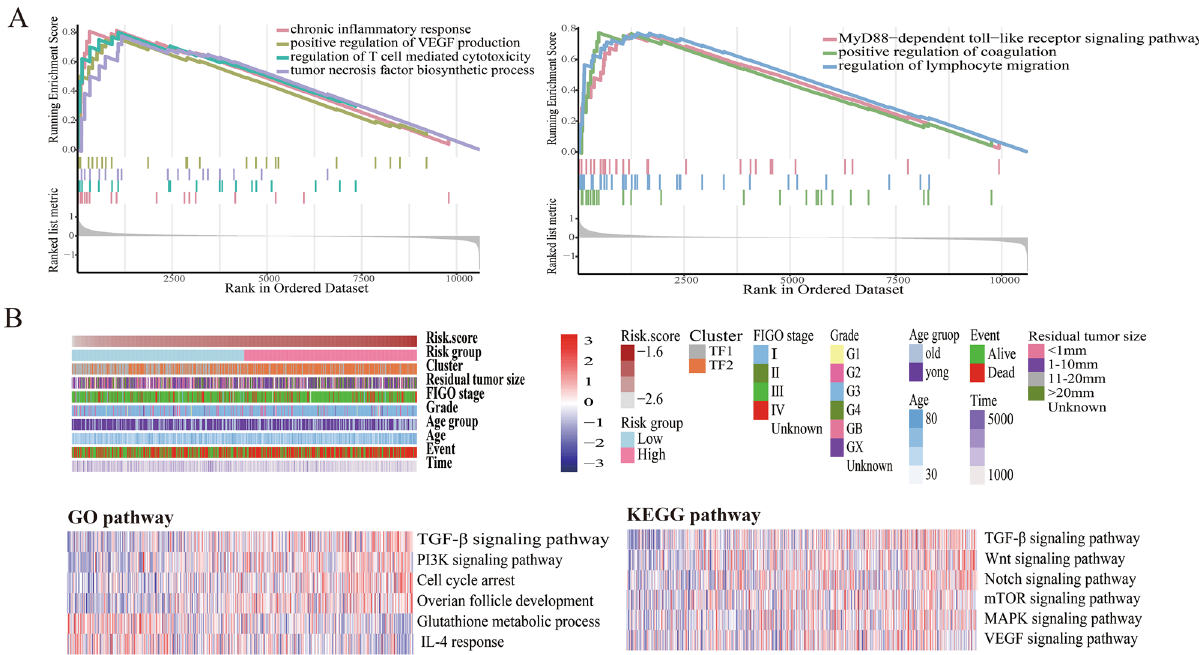
Figure 7. Functional annotation of TFs related prognostic signature. ( A ) GSEA assay to identify the different pathways between high-risk score group and low-risk score group; ( B ) GSVA assay to explore the distribution of risk scores and clinical features (upper), and gene set enrichment of different pathways in GO terms and KEGG pathways